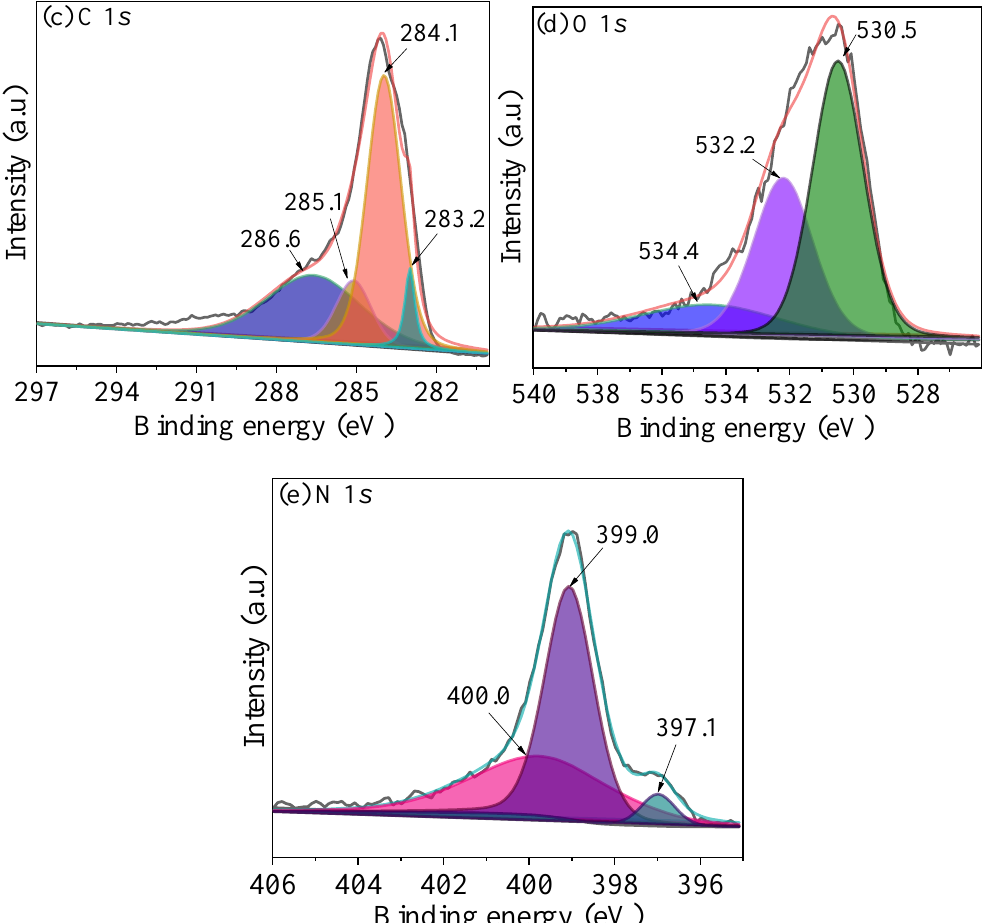
Figure 6. XPS spectra of ( a ) Kaolin, Fe 3 O 4 /Kaolin, PPy-Fe 3 O 4 /Kaolin, ( b ) Fe 2 p , ( c ) C 1 s , ( d ) O 1 s, and ( e ) N 1 s . Nanomaterials 2020 , 10 , x FOR PEER REVIEW